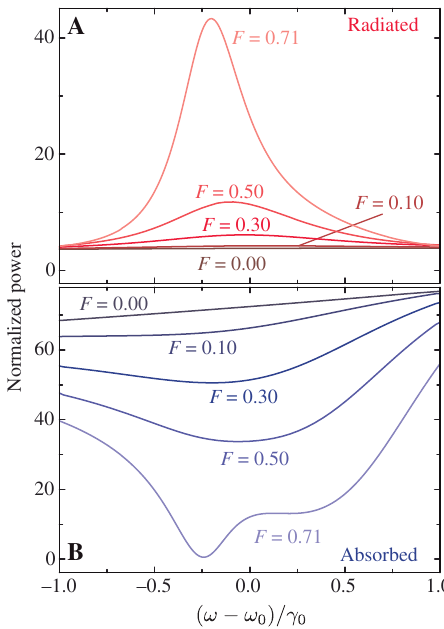
Figure 2: Detailed analysis of the absorbed and radiated power. Total power radiated (A) and absorbed (B) by the active–passive dimer when excited by a dipole source, calculated for increasing values of F . Both quantities are normalised to P